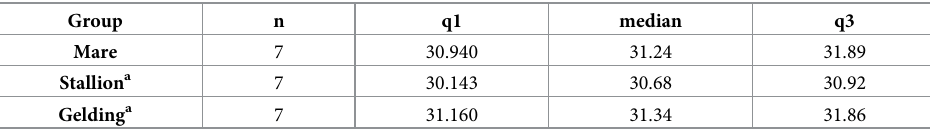
Table 3. Temperature values (TH) in the prosternum